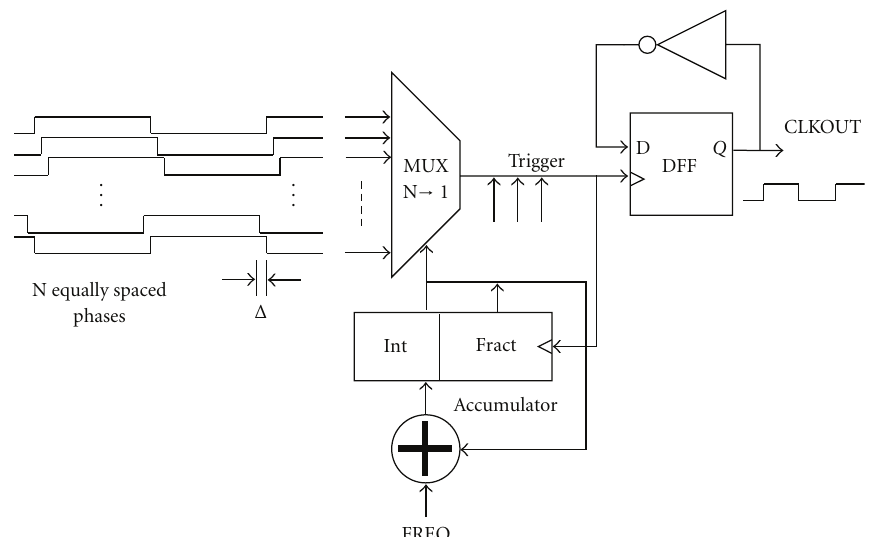
Figure 1: Block diagram of conventional flying adder [8].